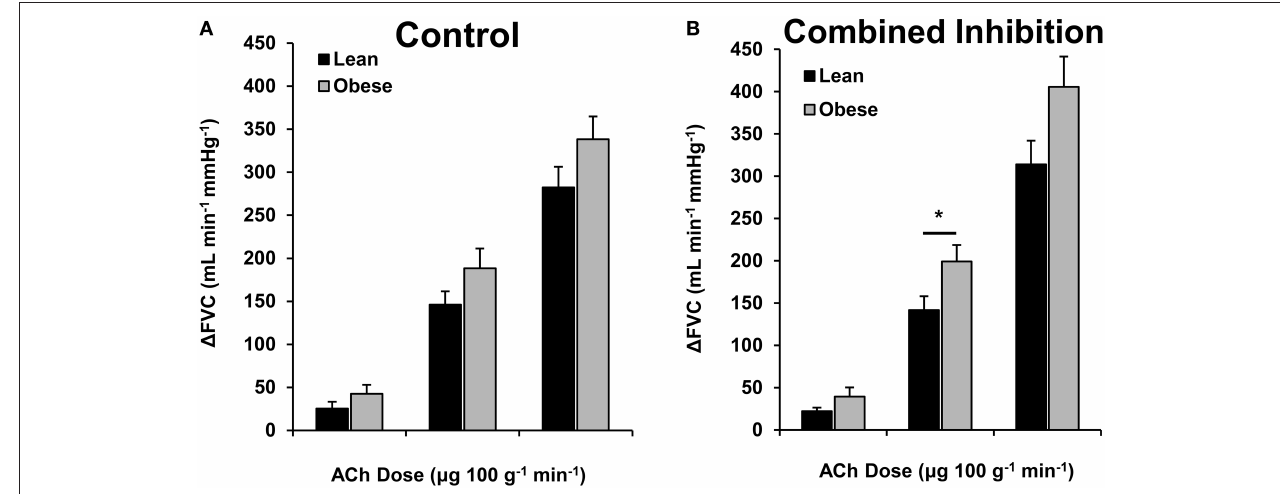
FIGURE 4 | ACh responses with combined inhibition. Change in forearm vascular conductance ( (cid:2) FVC) with intra-arterial ACh infusion and combined NOS-COX inhibition ( L -NMMA and Keto). (A) (cid:2) FVC was not different between lean ( n = 46 ) and obese ( n = 29 ) adults (same as Figure 1 ). (B) (cid:2) FVC with combined NOS-COX inhibition was greater in obese adults ( n = 29 ) than lean adults ( n = 46 ) at 4 µ g100 − 1 g min − 1 . * Significant group difference, p < 0.05 .